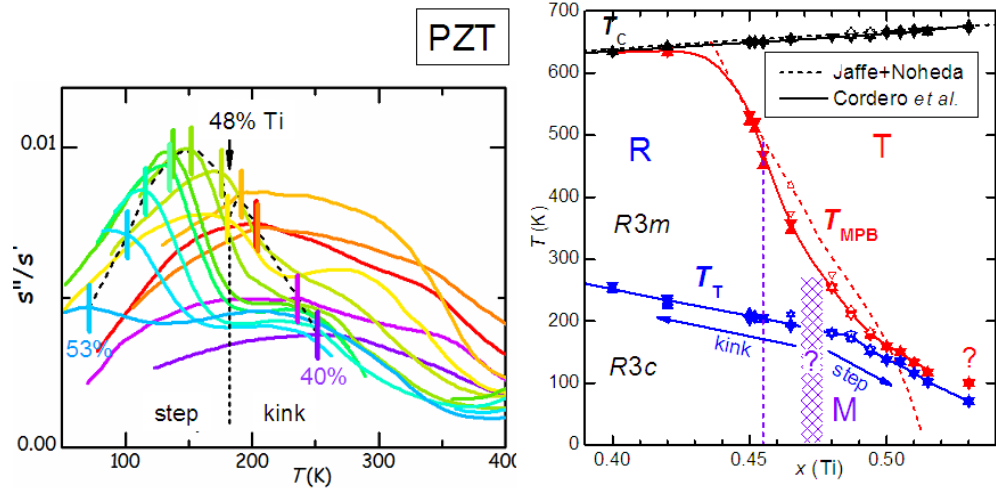
Figure 13. Elastic energy loss of PZT − x measured together with s (cid:48) shown in Figure 12 (data from Refs. [76,77]). The vertical bars indicate T T and are plotted in the detail of the MPB region of the phase diagram.